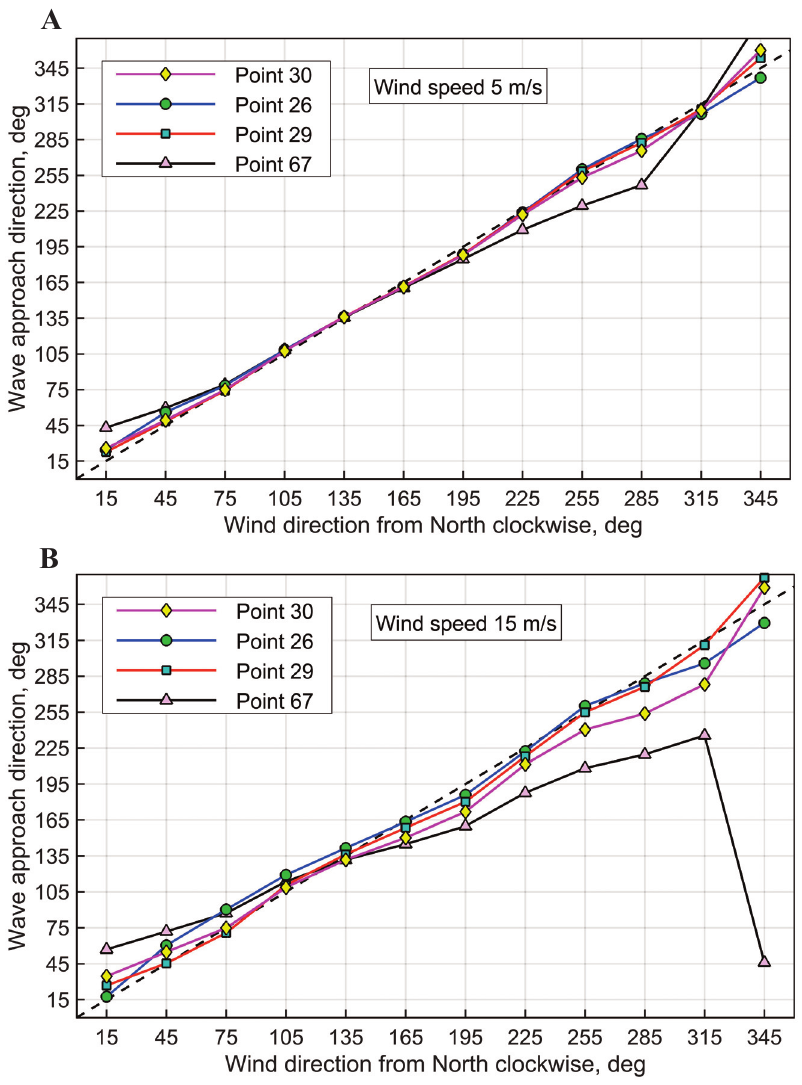
Fig. 6. Comparison of the wind direction and the mean direction of simulated wave propagation in saturated wave fields for wind speeds of 5 m/s (A) and 15 m/s (B) on the northern slope of Gretagrund (point 30, water depth 7.7 m), in the shallow area to the west of the grid (point 26, water depth 13 m), in the deep channel (point 29, water depth 21 m), and on the fairway to the Port of Ringsu (point 67). The locations of grid points are indicated in Fig.